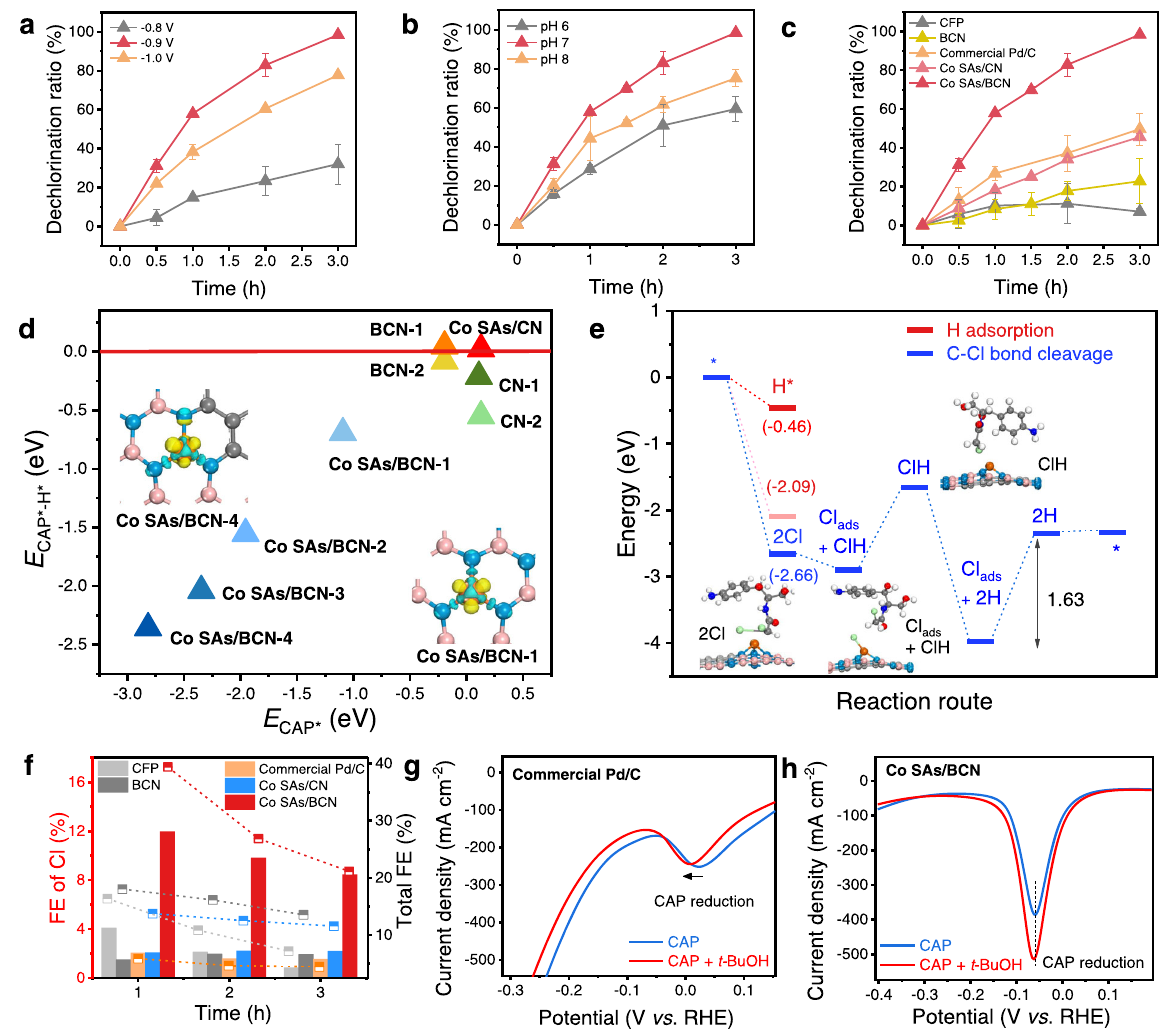
Fig. 4 Catalytic mechanism of CAP electrocatalytic dechlorination. a , b Dechlorination ratio of CAP on various cathode potentials and at different pHs over the Co SAs/BCN, respectively. c Dechlorination ratio of CAP on various catalysts after 3 h electrolysis at − 0.9 V. d Plot of the energy difference E CAP* − E E H* against the CAP* ; detailed structures are given for BCN-1 and BCN-2 (Supplementary Fig. 22), Co SAs/BCN-1 to CN-2, and Co SAs/CN (Supplementary Fig. 36). e Energy diagrams and intermediate states of CAP dechlorination on the Co SAs/BCN; the optimized structures are detailed in Supplementary Fig. 33. f Faradaic ef fi ciency (FE) of CAP reduction. Left axis denotes the FE of CAP dechlorination (histogram). Right axis denotes the total FE of CAP reduction (dashed line), including the dechlorination reaction and the NO 2 reduction of CAP. g , h Differential